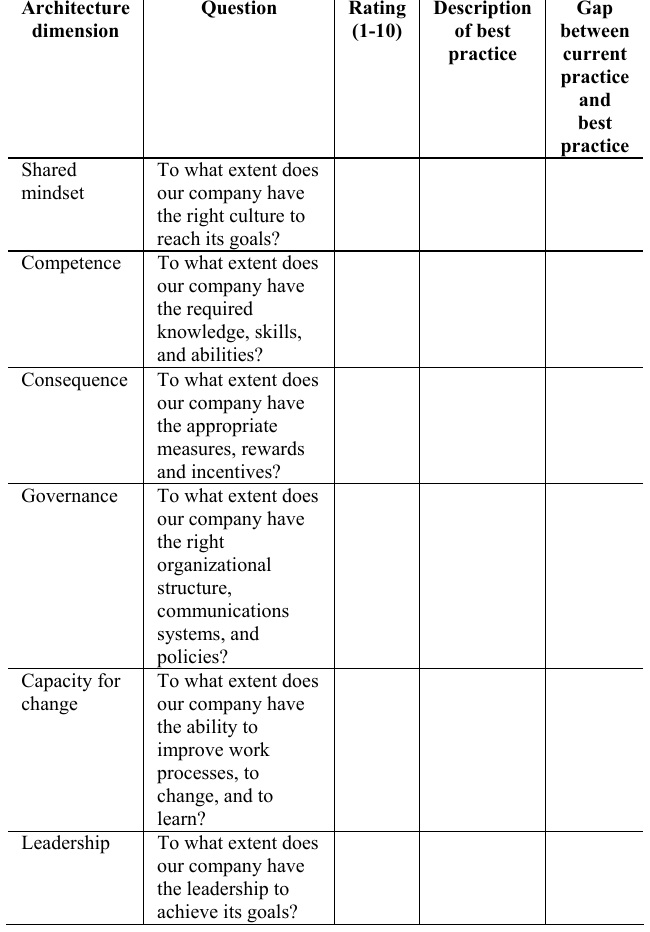
Table 1: Ulrich's (1998) organisational architecture example